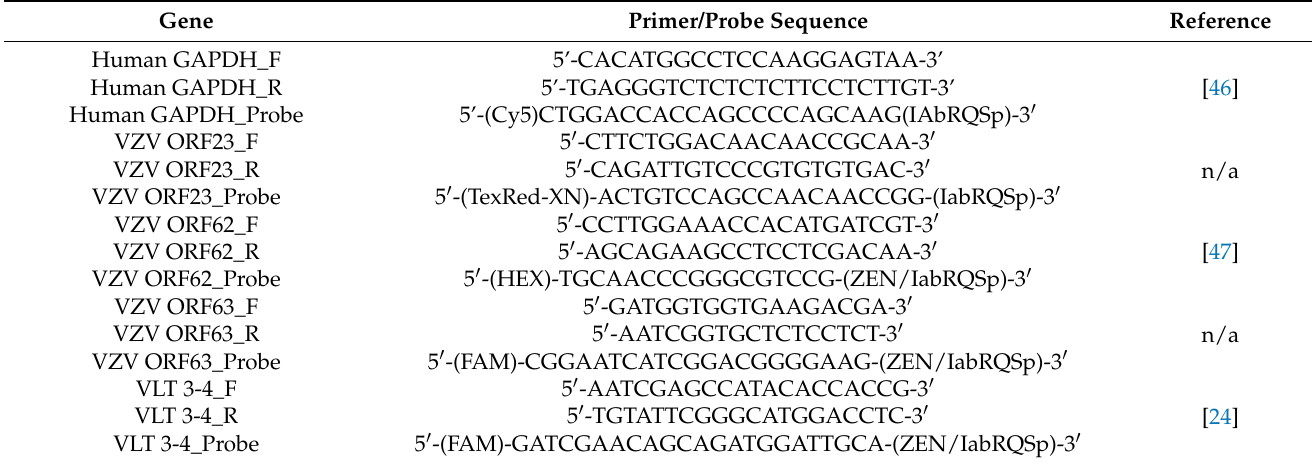
Table 1. Primer and probe sequences that were used in VZV multiplex.